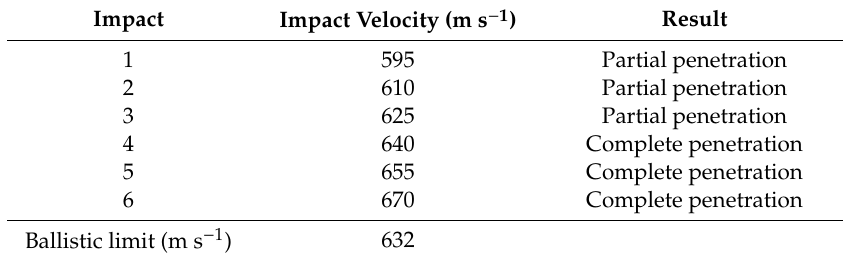
Table 8. Ballistic limit velocity of the helmet of aramid fabric impregnated with poly(BA-a-co-PU) 80 / 20 matrix containing 0.25 wt% MWCNTs predicted from the simulation